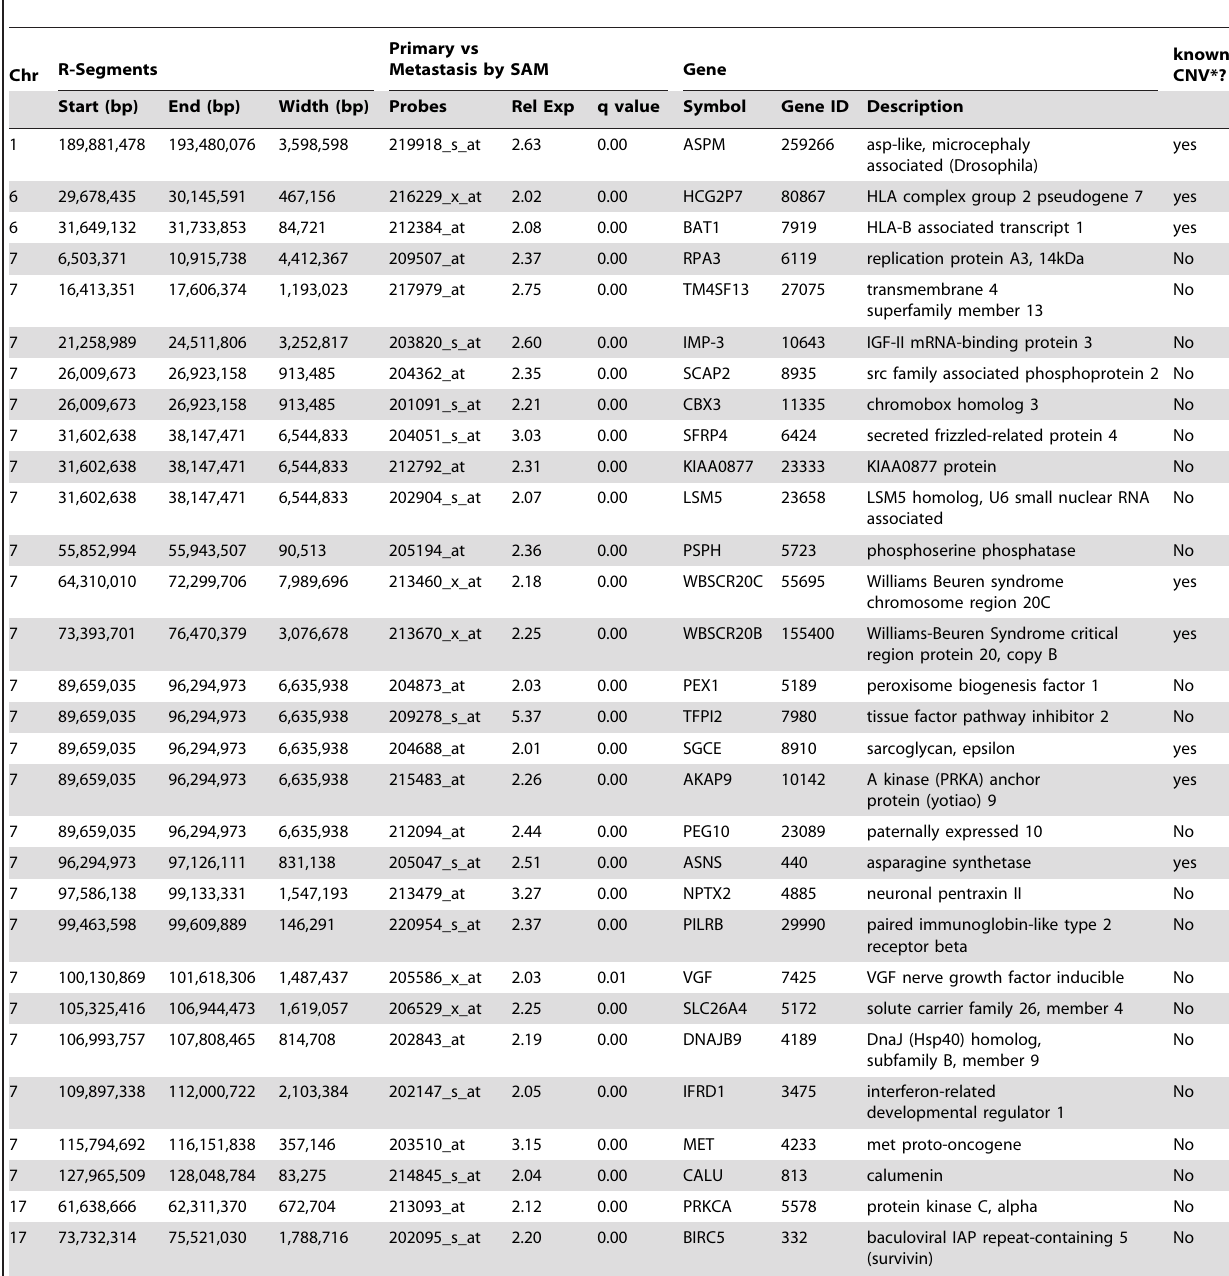
Table 2. The integration of copy number and expression analysis to compare primary and metastastic melanoma genomes identifies 30 unique genes amplified and overexpressed in metastastic melanoma compared to primary melanoma.